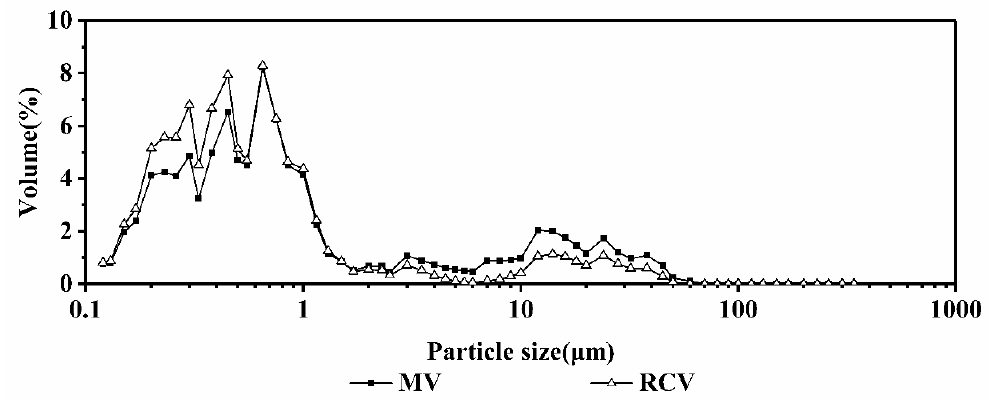
Figure 7. The particle size distribution of different concentrations of milk calcium-fortified milk systems at 95 °C.